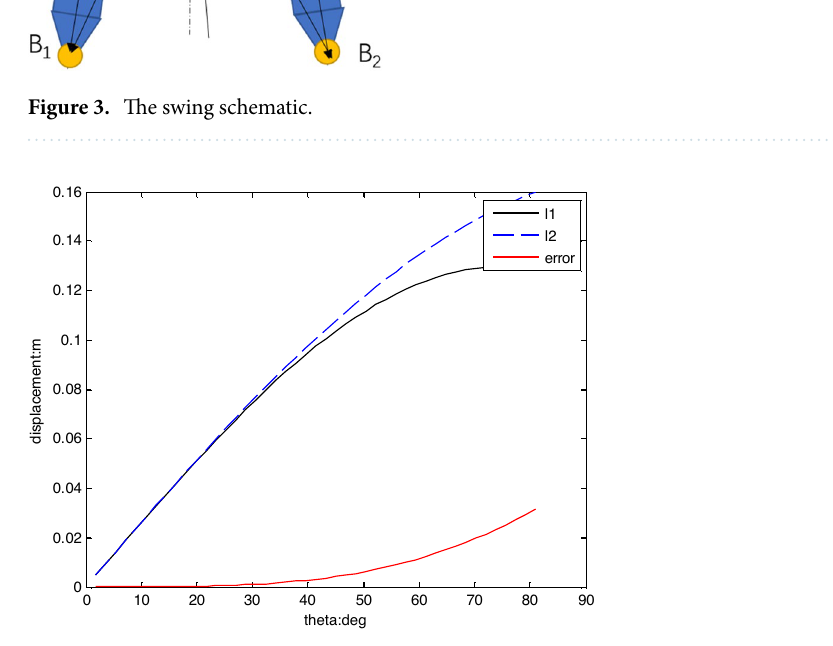
Figure 4. l 1 and l 2 when the swing rotates. (Kinematics model of the double actuated